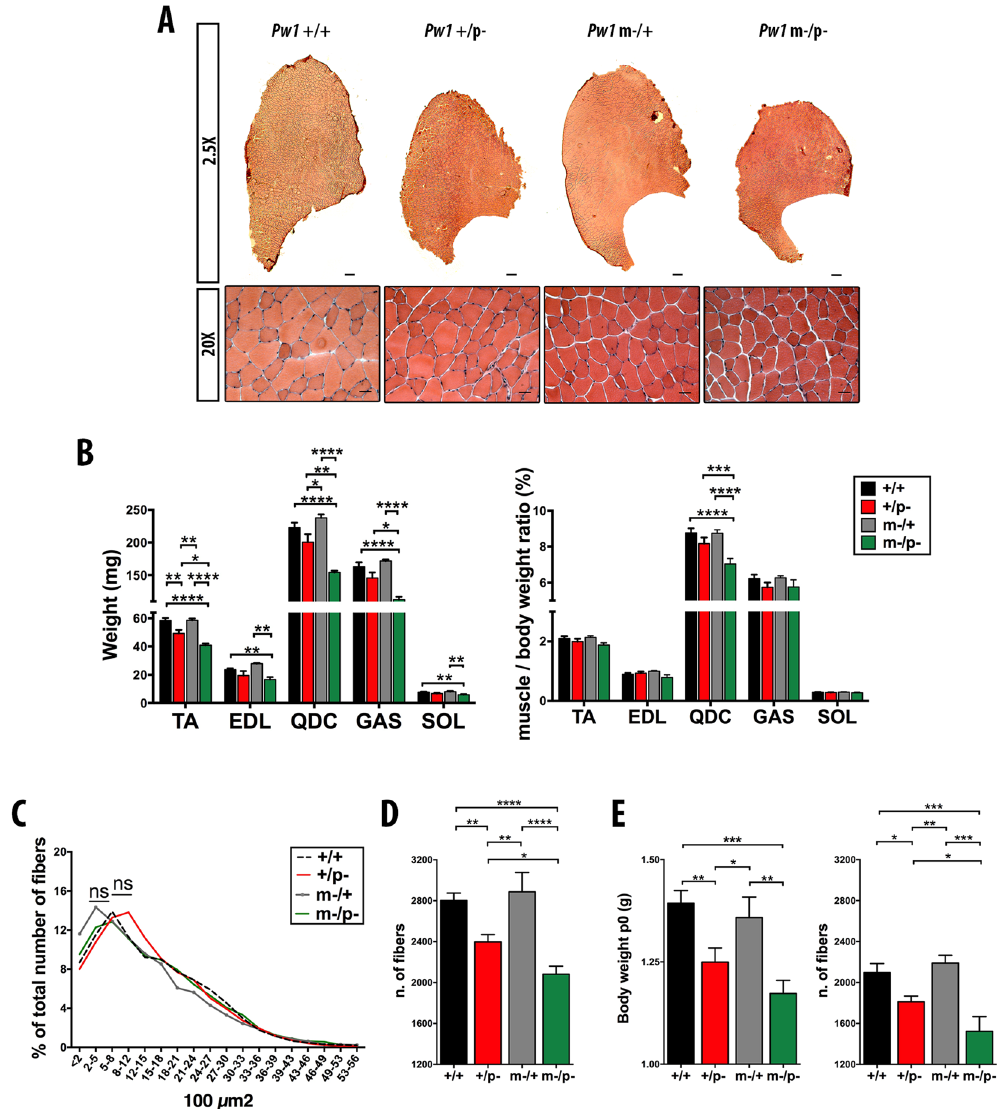
Figure 1. Pw1 is required for the establishment of muscle size and myofiber number. (A) Representative photomicrographs at lower (upper panel; scale bars = 200 μ m) and higher magnification (lower panel; scale bars = 50 μ m) of TA muscles cross-sections from 3 month Pw1 + / + , Pw1 + /p − , Pw1 m − / + and Pw1 m − /p − mice stained with hematoxylin and eosin. (B) Histograms showing the muscle weight (left panel) and muscle/body weight ratio (right panel) of Tibialis Anterior ( TA ), Extensor Digitorum Longus ( EDL ), Quadriceps ( QDC ), Gastrocnemius ( GAS ), Soleus ( SOL ) muscles from 3 month Pw1 + / + , Pw1 + /p − , Pw1 m − / + and Pw1 m − /p − mice (n = 10 for each genotype). Pw1 + /p − and Pw1 m − /p − muscles are smaller than Pw1 + / + and Pw1 m − / + muscles. Pw1 m − /p − TA , QDC and GAS muscles are smaller than Pw1 + /p − TA , QDC and GAS muscles. (C) Fiber size distribution in 3 month Pw1 + / + (dash), Pw1 + /p − (red), Pw1 m − / + (grey) and Pw1 m − /p − (green) TA . Values represent the mean number ± s.e.m. per 100 fibers (n = 5 for each genotype). Statistical analyses were performed using Student’s t-test. Pw1 depletion did not result in fibers area differences. (D) Histograms representing the fiber number in 3 month Pw1 + / + , Pw1 + /p − , Pw1 m − / + and Pw1 m − /p − TA muscles sectioned through the midbelly region (n = 7 for each genotype). The number of fibers is decreased in Pw1 + /p − and Pw1 m − /p − TA muscles as compared to Pw1 + / + and Pw1 m − / + TA muscles. Pw1 m − /p − TA muscles have reduced number of muscle fibers as compared to Pw1 + /p − . (E) Left panel-Histograms showing total body weight of postnatal day 0 (P0) Pw1 + / + , Pw1 + /p − , Pw1 m − / + , and Pw1 m − /p − mice (n = 14 for each genotype). Pw1 + /p − and Pw1 m − /p − are smaller as compared to Pw1 + / + and Pw1 m − / + mice. Right panel-Histograms representing the fibers number in P0 Pw1 + / + , Pw1 + /p − , Pw1 m − / + , and Pw1 m − /p − mice TA muscles (n = 5 for each genotype). Pw1 + /p − and Pw1 m − /p − TA have less fiber as compared to Pw1 + / + . Pw1 m − /p − TA displays less number of fibers as compared to Pw1 + /p − TA . Values are expressed as mean ± s.e.m. Statistical analyses were performed using one-way ANOVA and Tukey’s post-test for multiple comparison * P < 0.05, ** P < 0.01 and *** P < 0.001 (n ≥ 4); n.s., not significant. In all the graphs Pw1 + / + ( + / + ), Pw1 + /p − ( + /p − ), Pw1 m − / + (m − / + ), and Pw1 m − /p − (m − /p −